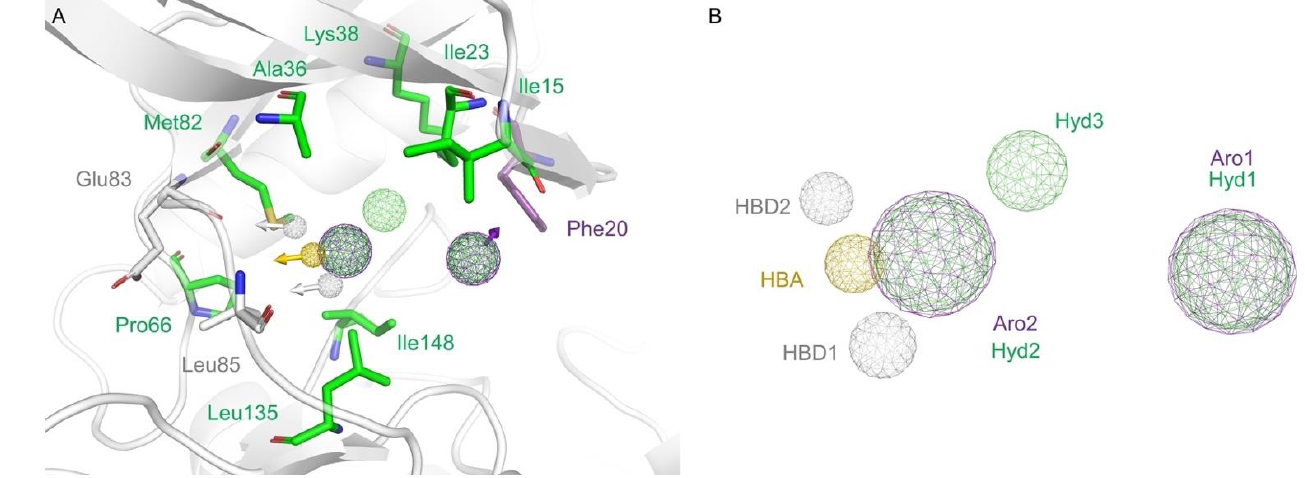
Figure 4. Pharmacophore modeling. ( A ) CK1ε catalytic site representation with selected amino acids showed on licorice model. Residues forming hydrophobic interactions, hydrogen bonds, or stacking interactions are colored green, yellow and white, or purple, respectively. ( B ) The generated pharmacophore model included eight elements. Hydrogen bond donors (HBD) are represented as sphere grid colored white, hydrogen bond acceptor (HBA) on yellow, aromatic (Aro) on purple, and hydrophobic (Hyd) on green.